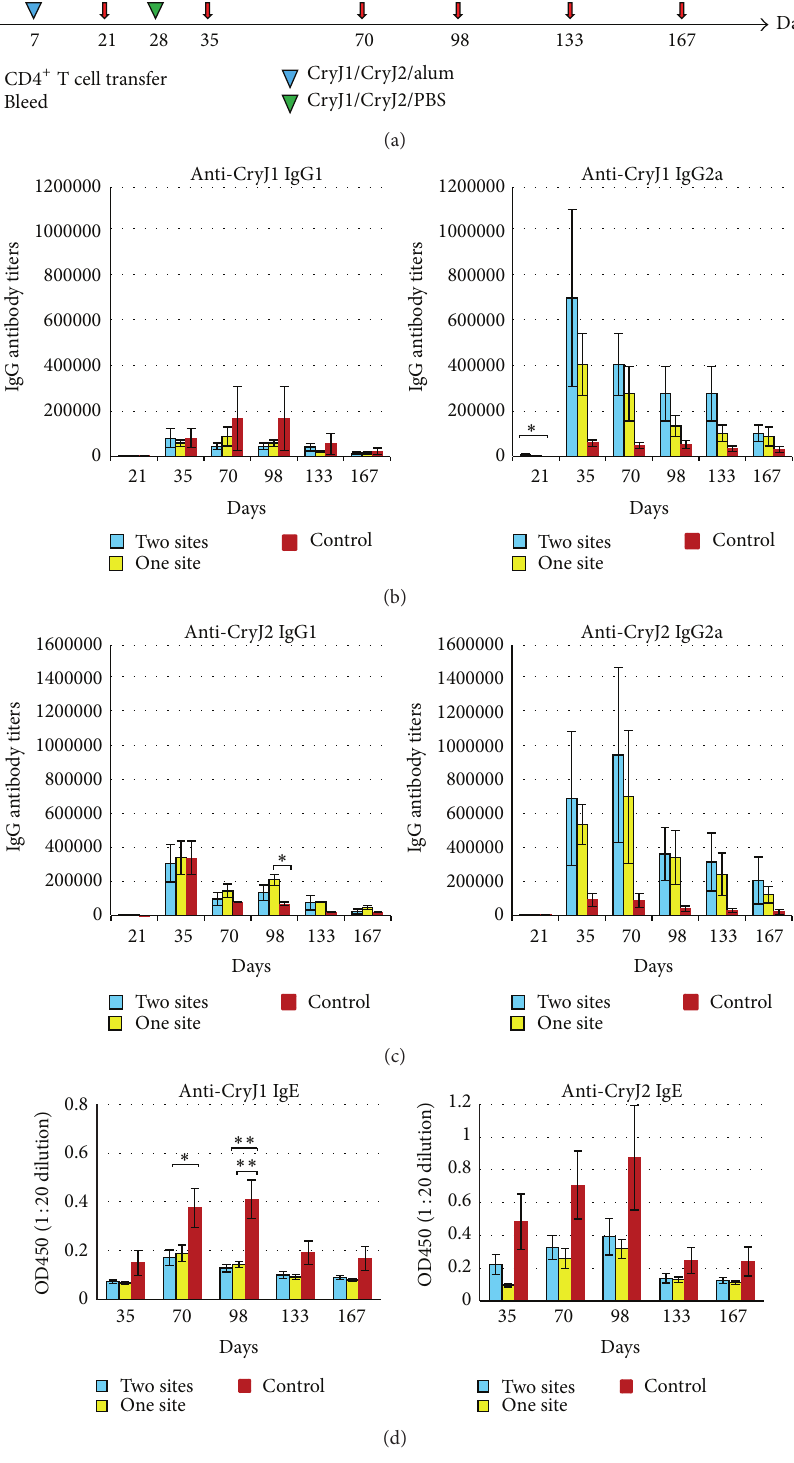
Figure 5: DNA vaccination induces CD4 + T cell memory response. (a) Schematic view of vaccination protocol. Three groups of mice were immunized with control vector, 50 𝜇 g CryJ1-LAMP and 50 𝜇 g CryJ2-LAMP in one injection (one site), or the same amount of CryJ1-LAMP and CryJ2-LAMP separately on flanks (two sites) three times (weekly) by Biojector injection. Two weeks after the last injection, mice were sacrificed and spleens were removed. CD4 + T cells were isolated and 1 × 10 7 CD4 + T cells per mouse were transferred into na¨ıve mice accordingly ( 𝑛 = 5 ) on day 0 by intravenous injection. Recipients were then boosted with 5 𝜇 g CryJ1 and 5 𝜇 g CryJ2 and bled as indicated. Anti-CryJ1 (b) and anti-CryJ2 (c) IgG1 and IgG2a antibodies were analyzed by ELISA. (d) Anti-CryJ1 and anti-CryJ2 IgE antibodies were determined by ELISA and depicted are results of OD 450 values at a serum dilution of 1:20. The OD 450 values of prebleed samples are below 0.06. All data are shown as mean ± SEM. ∗ 𝑝 < 0.05 and ∗∗ 𝑝 < 0.01